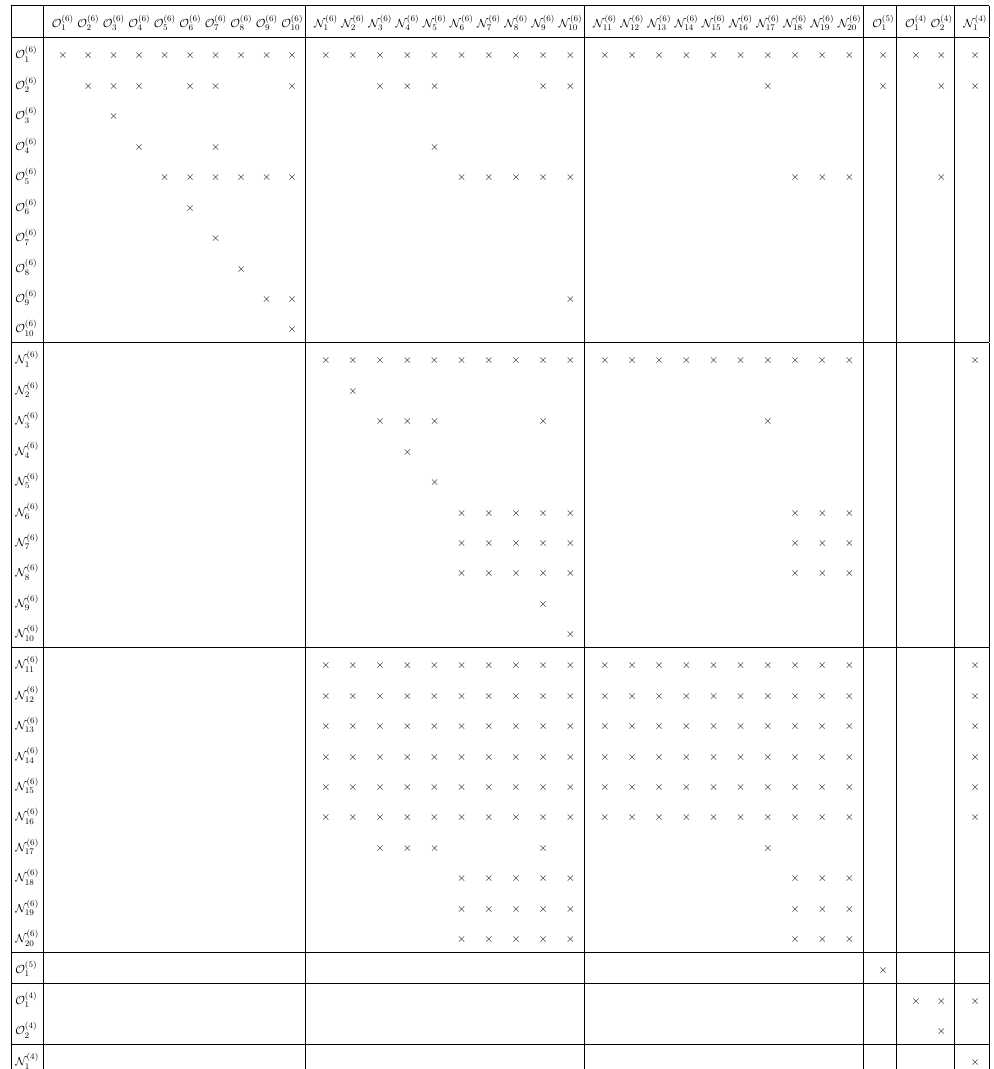
Table 1 . Structure of the inverse mixing matrix Z (cid:0) 1 , de(cid:12)ned in (2.2). The operators are de(cid:12)ned in (3.24), (3.25), (3.27), (3.28), and (3.29). The operator O (6) The divergence of the axial current, O (4)